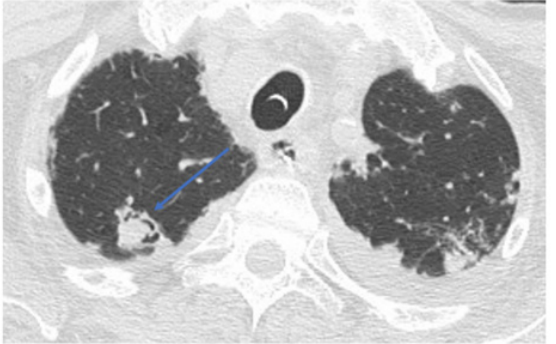
Figure 4. CT chest scan showing a lesion suspected as aspergilloma, as pointed out by blue arrow. Legend: blue arrow shows lesions suggestive of aspergilloma.